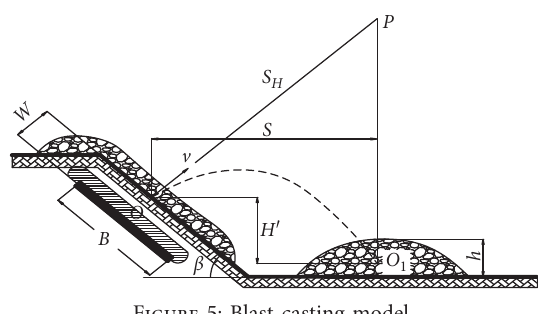
Figure 5: Blast-casting